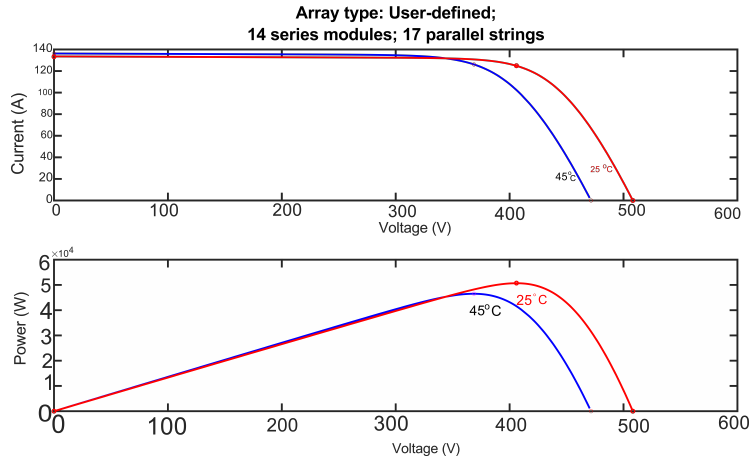
Figure 20. Illustration of PV array power generation with respect to irradiance and weather temperature.